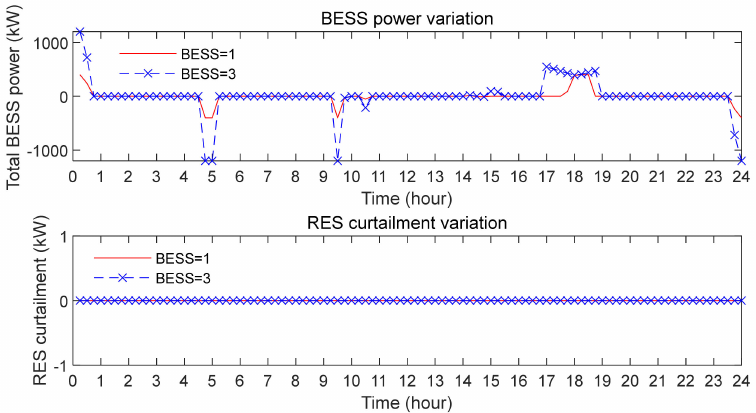
Figure 13. Variations of BESS power and RES curtailment for load type B (the distribution operator is able to sell electricity to the utility grid).